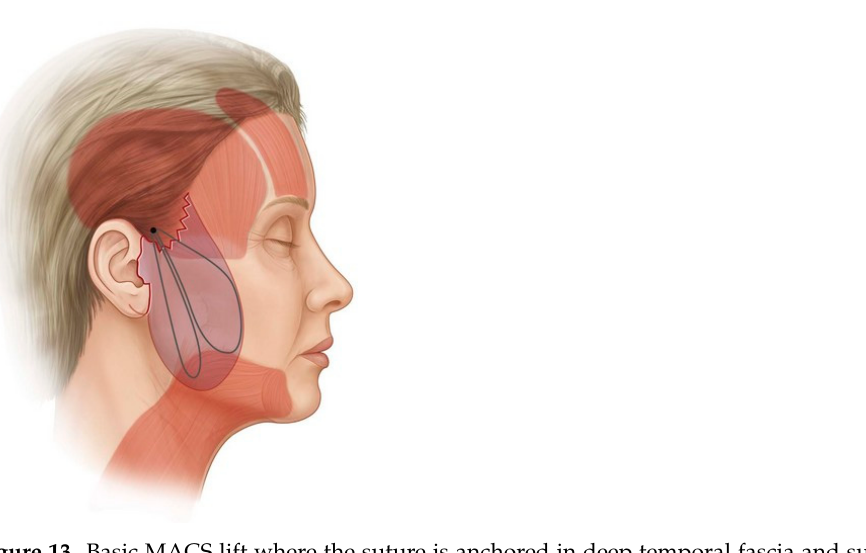
Figure 13. Basic MACS lift where the suture is anchored in deep temporal fascia and sutures are looped in a purse-string fashion [37]. Table 1. Comparison of different available barbed suture devices (Highlighted rows: Currently used commercial barbed sutures available for different surgical